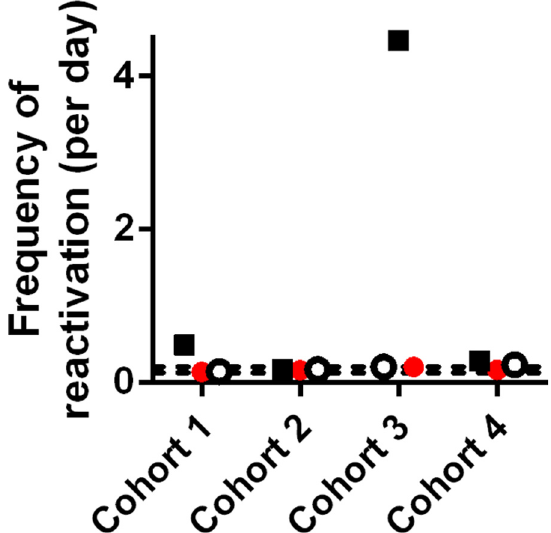
Fig 2. Frequency of HIV reactivation from latency estimated using different models: The mean frequency of reactivation estimated using the original model (red circles, corresponding to panels A – D of Fig 1), Hill ’ s model with slow growth rate (black squares, panels E – H of Fig 1), or Hill ’ s model with growth rate estimated from cohort 1 (open black circles, I – L of Fig 1) is shown. The frequency of reactivation estimated in Pinkevych et al. [2] is shown as dashed